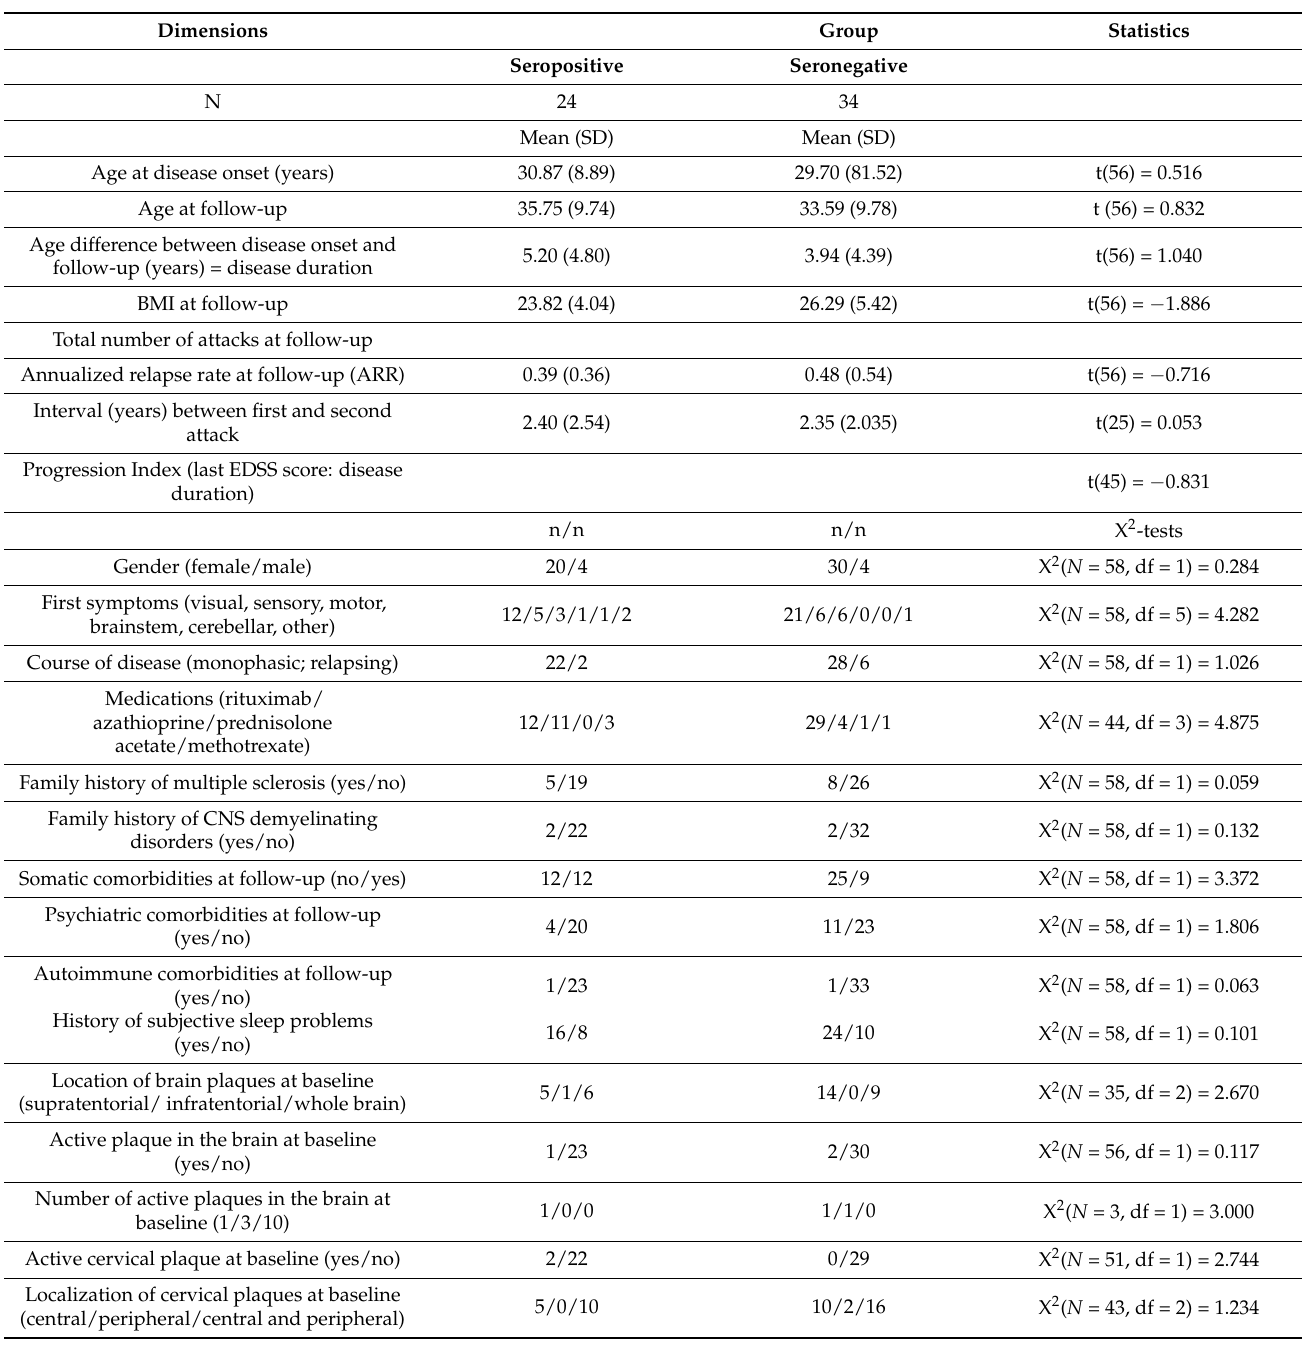
Table 2. Sociodemographic and illness-related information between seropositive and seronegative individuals with